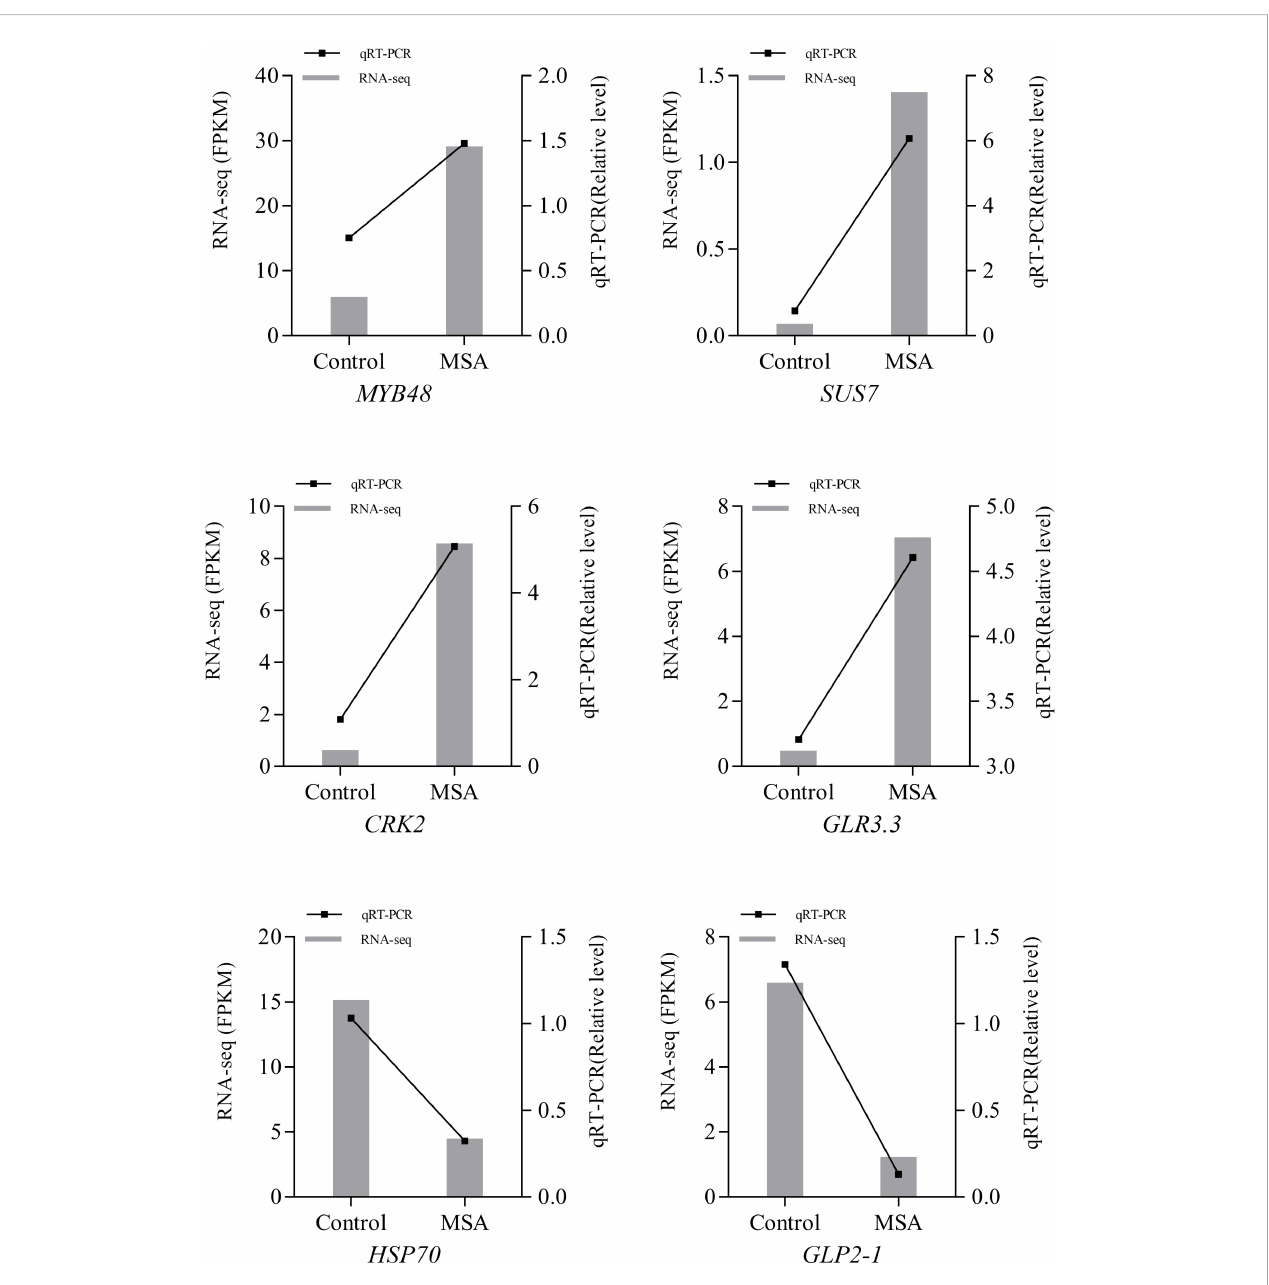
FIGURE 10 Quantitative Real-Time PCR (qRT-PCR) validation of differential expression genes. Control, 0 mM; MSA, 40 mM. MYB48 , transcription factor MYB48; SUS7 , Sucrose synthase 7-like; CRK2 , Cysteine-rich receptor-like protein kinase 2; GLR3.3 , Glutamate receptor 3.3; HSP70 , Heat shock 70 kDa protein; GLP2-1 , germin-like protein